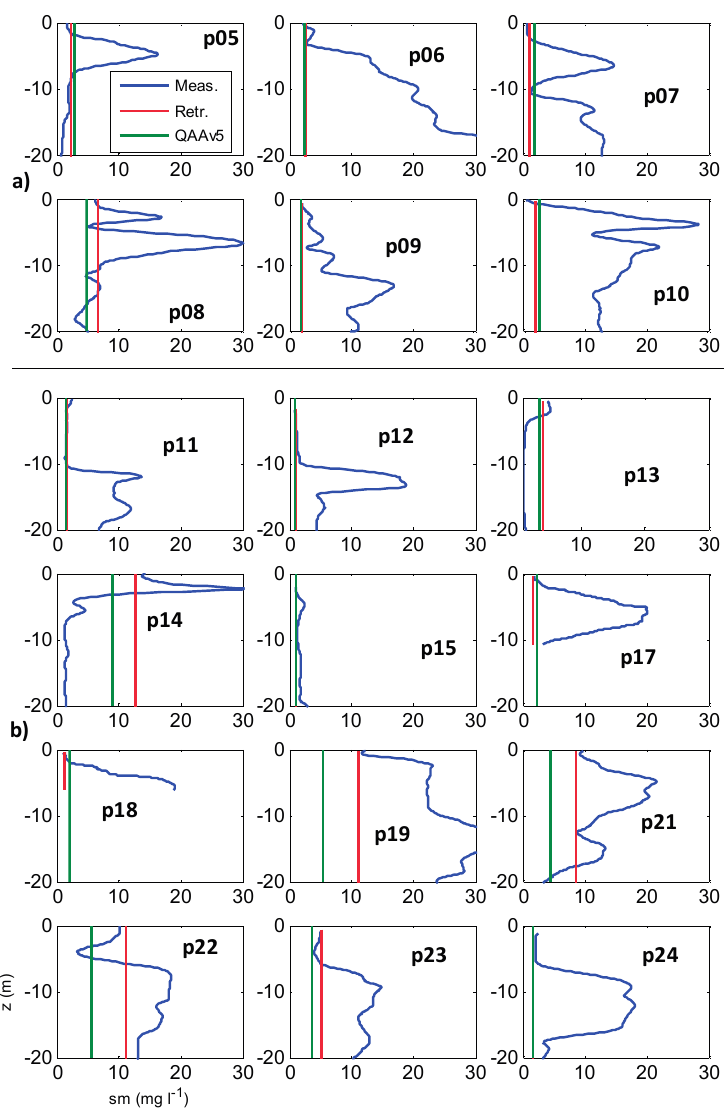
Figure 9. The QAA seems to underestimate high sm values. Figure 9. Measured sm profiles sm(z) (blue), retrieved constant sm profiles sm QAA retrievals (green). The red line is hardly visible in the cases with very good